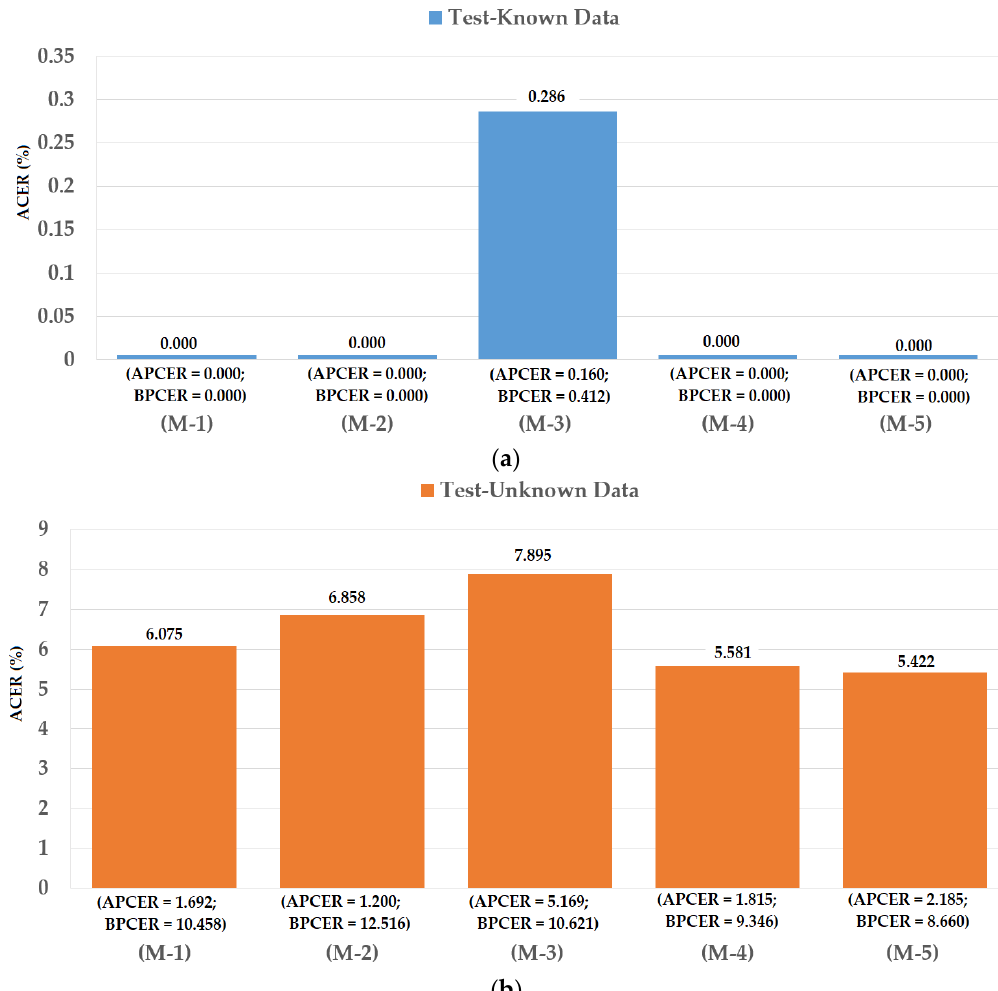
Figure 18. Detection errors of various iPAD methods using the fused dataset of Warsaw2017 and ND2015 datasets: ( a ) Using Test-Known dataset; and ( b ) Using Test-Unknown dataset. Note: (M-1) Using CNN as Classifier; (M-2) Using CNN Features with PCA and Polynomial SVM Kernel; (M-3) Using MLBP Features with PCA and Polynomial SVM Kernel; (M-4) Using Feature Level Fusion with PCA and Polynomial SVM Kernel; and (M-5) Using Score Level Fusion with PCA and (Linear– Polynomial) SVM Kernels.